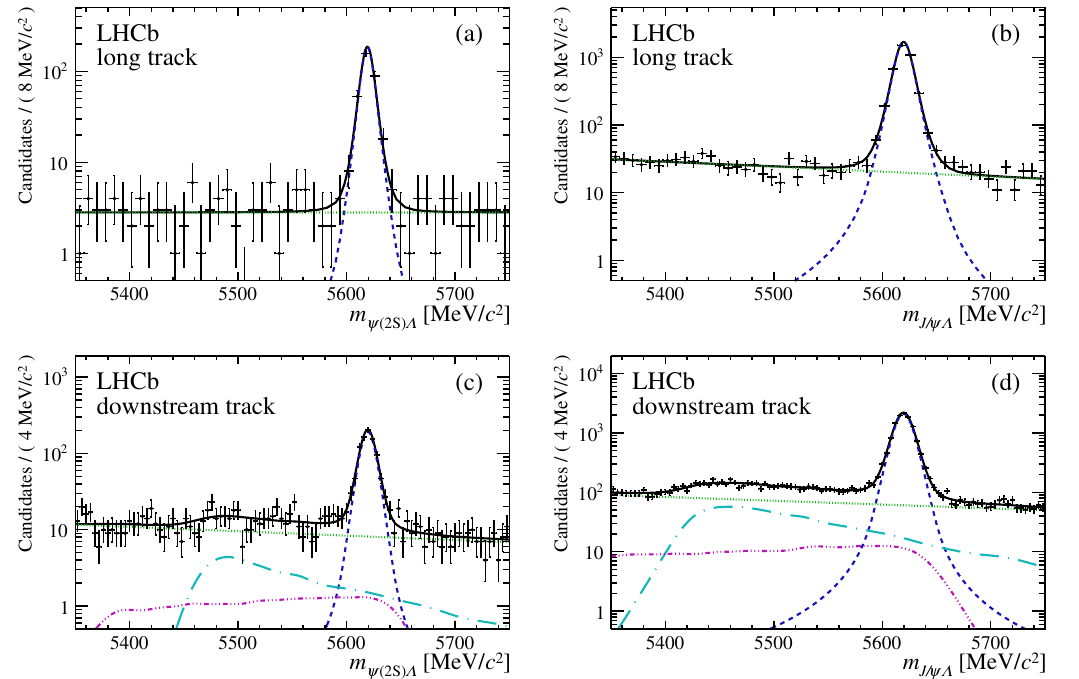
Figure 2 . Fits to the (unweighted) invariant-mass distributions of long-track candidates for (a) (cid:3) 0 ! (2 S ) (cid:3) and (b) (cid:3) 0 ! J= (cid:3) and for downstream-track candidates for (c) (cid:3) 0 b b and (d) (cid:3) 0 ! J= (cid:3) candidates. The signal (blue, dashed), the combinatorial background (green, b dotted), the B 0 ! K 0 background (cyan, long-dash-dotted) and the (cid:4) (cid:0) S (violet, dash-triple-dotted) are indicated.